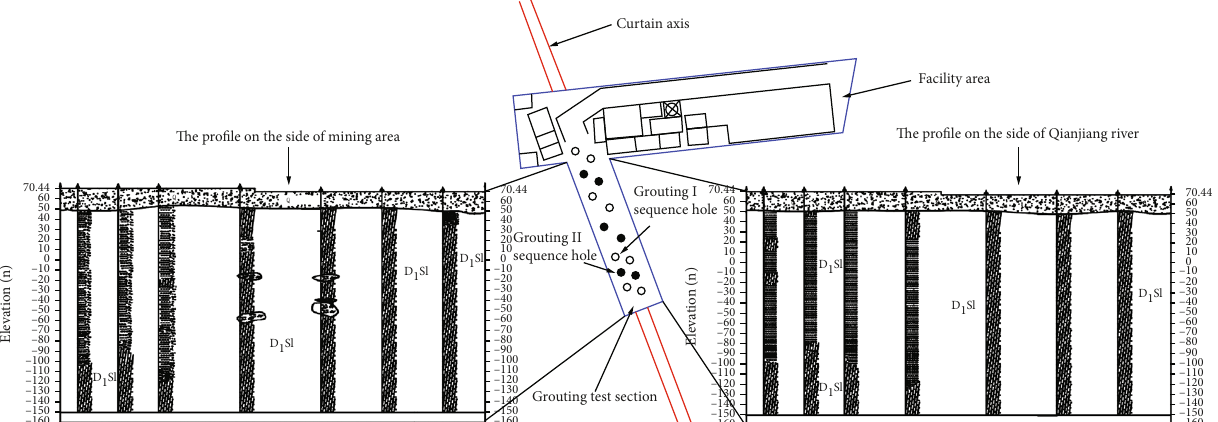
Figure 6: The plane layout and pro fi le of the northern grouting test section.